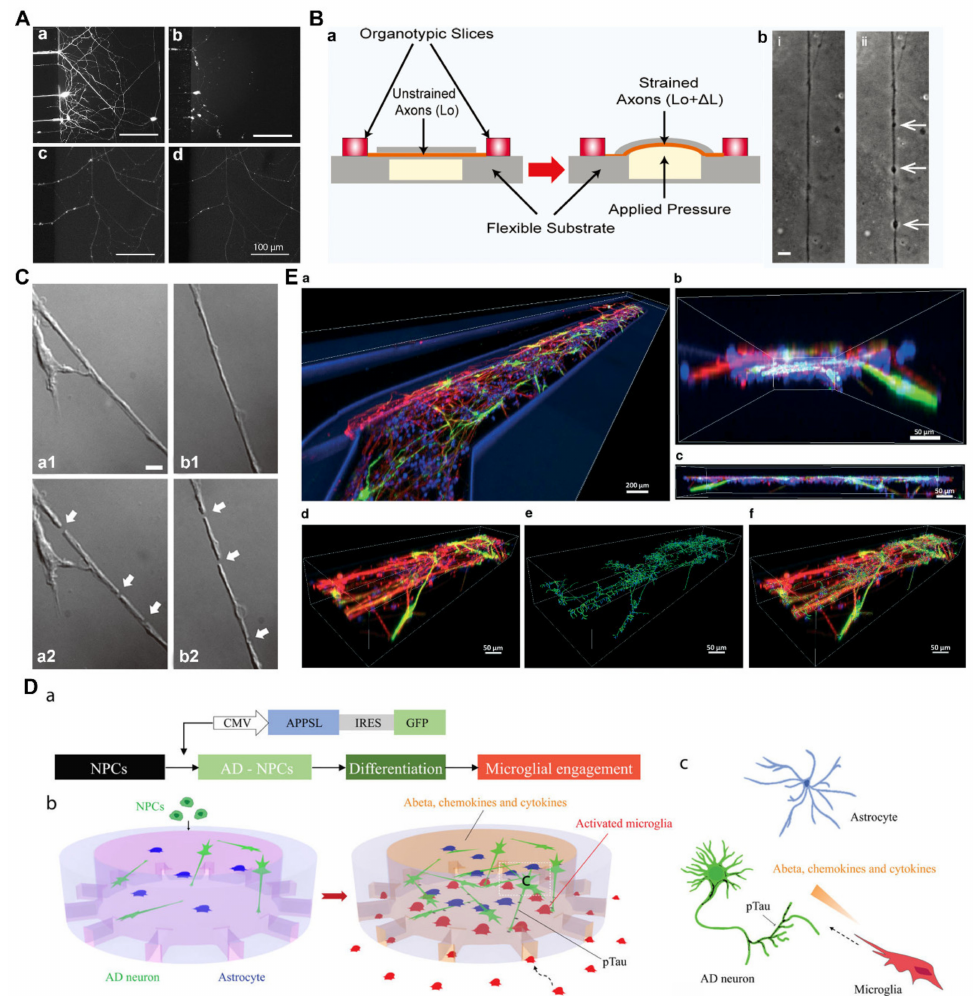
Figure 3. Engineering neural damage models using microfluidics. ( A ) Paclitaxel induced local axonal degeneration. Axons led to degeneration upon the axonal administration of paclitaxel for 24 h ( a , b ), but not with paclitaxel application to the soma chamber ( c , d ) (( a , c ) = before paclitaxel; ( b , d ) = after paclitaxel). ( B ) A brain-on-a-chip to model mechanical axonal injury. Schematic of the uniaxial axonal strain device ( a ). Representative images of axonal beading (arrows) observed before (i) and after (ii) the strain injury ( b ). ( C ) A neuro-optical microfluidic device for precise axotomy. Reproducible spot damage (arrows) ( a1 , a2 ). Severity of spot damage using different laser energies (arrows) ( b1 , b2 ). ( D ) A 3D tri-culture microfluidic platform to model in vitro Alzheimer’s disease (AD). Schematic of the differentiation of neural progenitor cells (NPCs) to Alzheimer’s disease neurons and astrocytes ( a ). Schematics showing the multicellular interactions in the microfluidic AD model ( b ) and in the AD brain tissue ( c ). ( E ) A 3D microfluidic cell culture system to model in vitro Parkinson’s disease. Representative images of the 3D distribution of differentiated dopaminergic neurons. Top view of the entire culture chamber ( a ). Inside view ( b ) and side view ( c ) of a selected area. Top view of the selected area ( d ), reconstruction of the neuronal filaments of tyrosine hydroxylase (TH) and TUB β III- positive neurons in the selected area ( e ), and overlap ( f ) of ( d , e ). ( A ) Adapted with permission from Ref. [82]. Copyright 2009, Elsevier; ( B ) Adapted with permission from Ref. [85]. Copyright 2014, World Scientific Publishing Co.; ( C ) Adapted with permission from Ref. [86]. Copyright 2009, the Royal of Society of Chemistry; ( D ) Adapted with permission from Ref. [88]. Copyright 2018, Nature; ( E ) Adapted with permission from Ref. [89]. Copyright 2015, the Royal of Society of Chemistry. Mechanical damage is also an important and common form of neural injury. Mi- crofluidic platforms have provided various in vitro models for mechanical injuries in